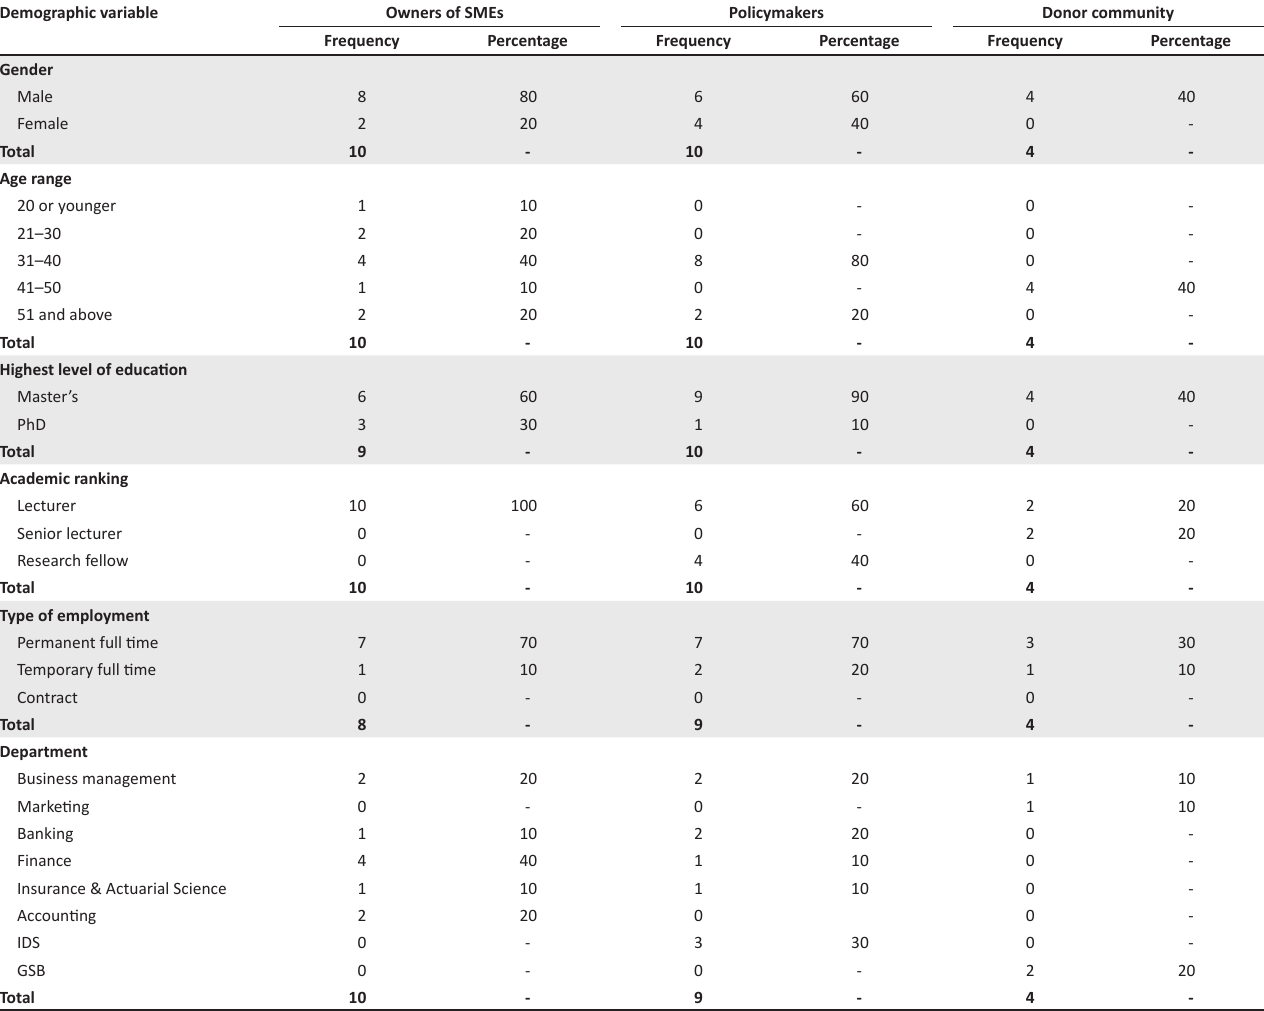
TABLE 3: Respondents’ beneficiaries of only those who did not disseminate their results ( N = 10). Demographic